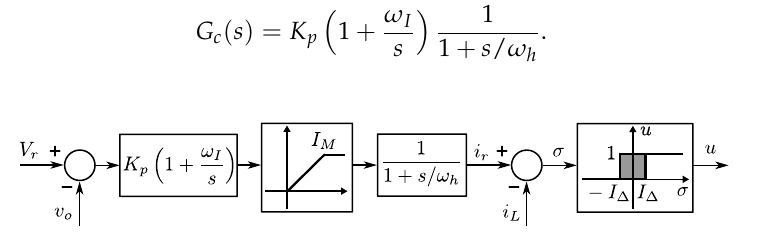
Figure 4. Control scheme with a double loop voltage